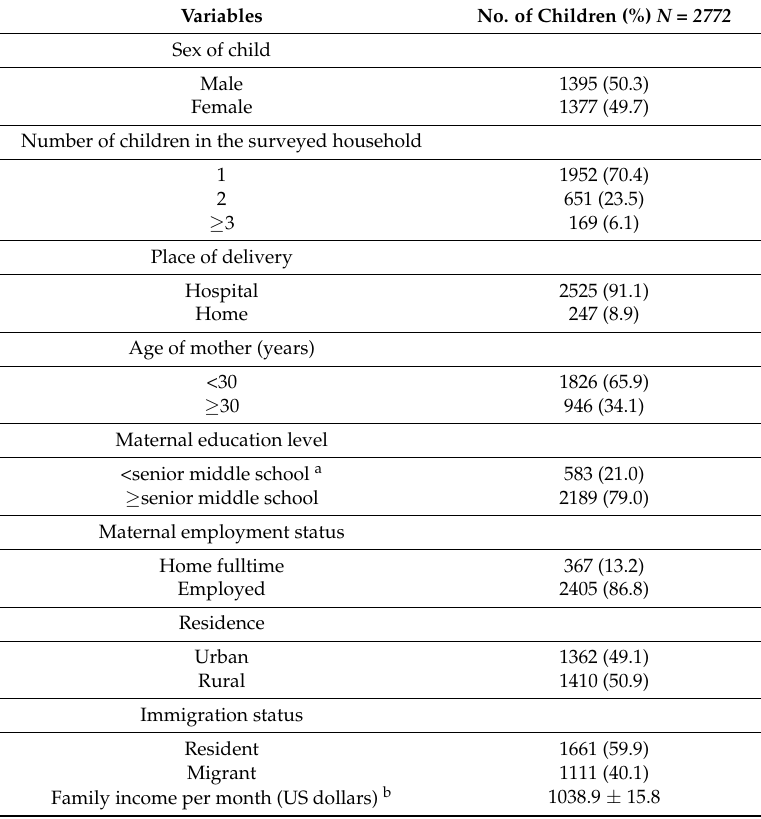
Table 1. Summary distribution of the demographic and socio-economic characteristics of children aged 24–36 months, in Zhejiang